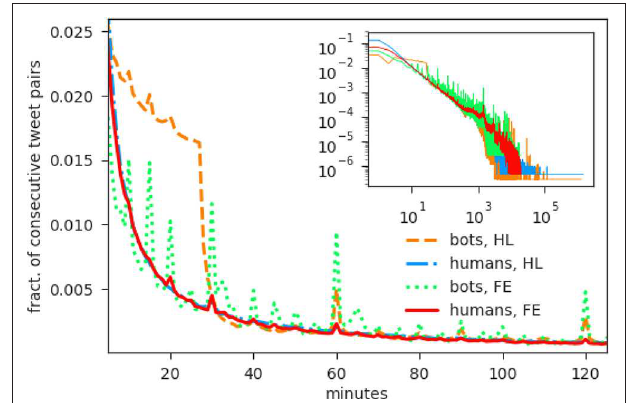
FIGURE 2 | Inter-time distribution between two consecutive tweets. For both datasets and both categories of accounts, we plot the fraction of pairs of consecutive tweets that occurred with a given time separation ( inter-time ). The overall distribution is reported in the inset, while the main picture shows a detailed view of the inter-times between 10 min and 2 h. The overall distribution exhibits the characteristic long tail for both humans and bots. The detail reveals the presence of peaks corresponding to regular values (10 min, a quarter of an hour, half an hour and so forth); the peaks are present both in the humans’ and bots’ distribution, but they are much more marked in the latter.